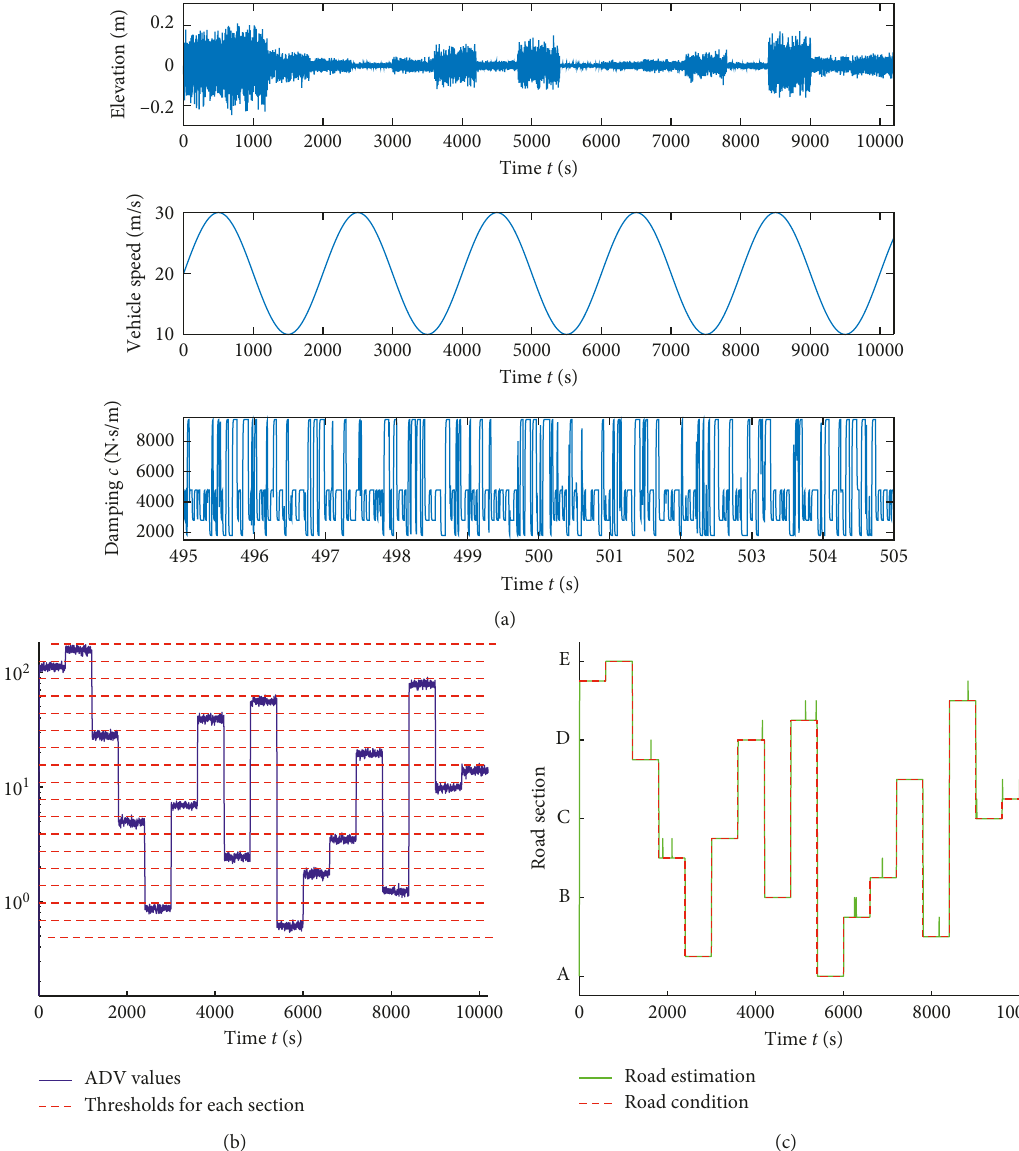
Figure 13: The performance of road classification on variable conditions. (a) Road classification working condition. (b) ADV values. (c) Road roughness classification results and corresponding road roughness